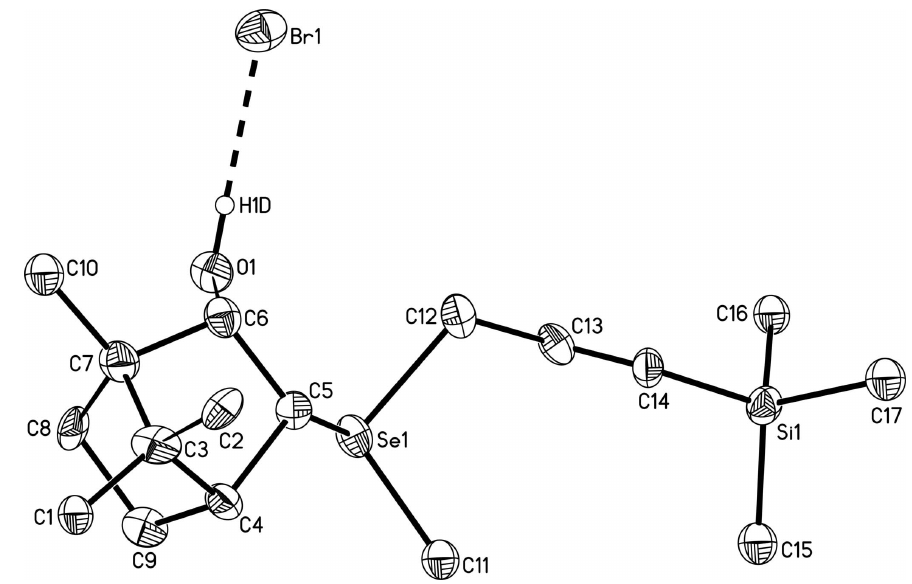
Figure 1 View of the title compound, showing the labelling of the non-H atoms and 30% probability ellipsoids. H atoms have been omitted for clarity, except for H1D which is involved in hydrogen bonding.